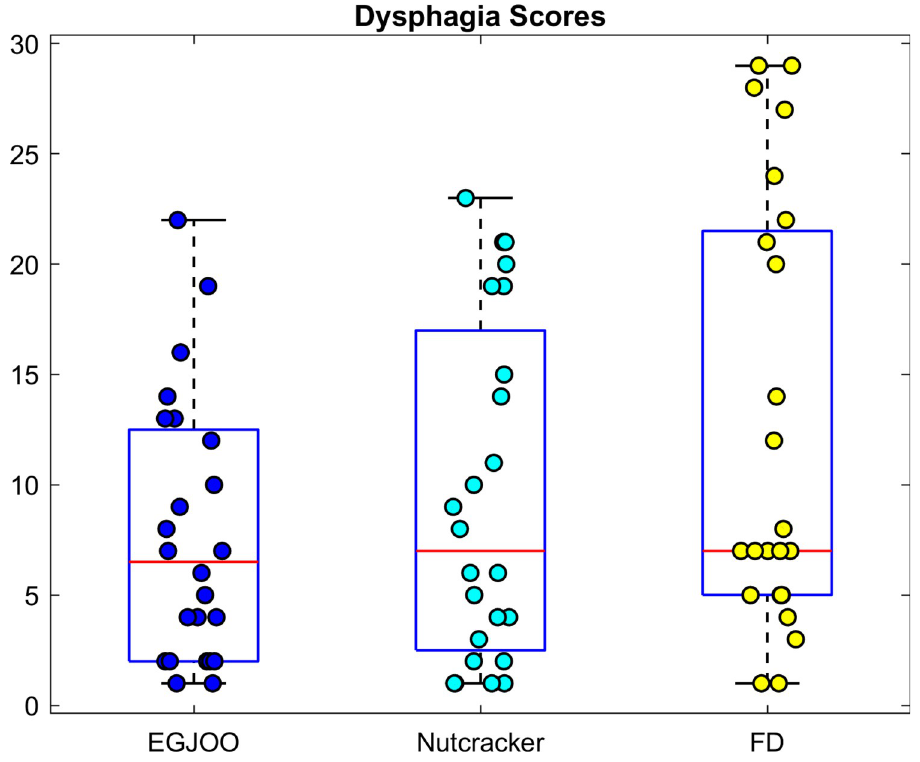
Fig 6. Dysphagia scores in 3 group of patients are not different. EGJOO = esophagogastric junction outflow obstruction, FD = functional dysphagia, and NC = nutcracker